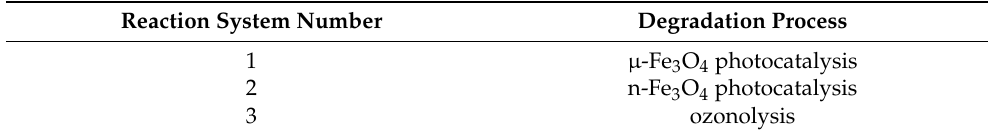
Table 1. Summary of reaction